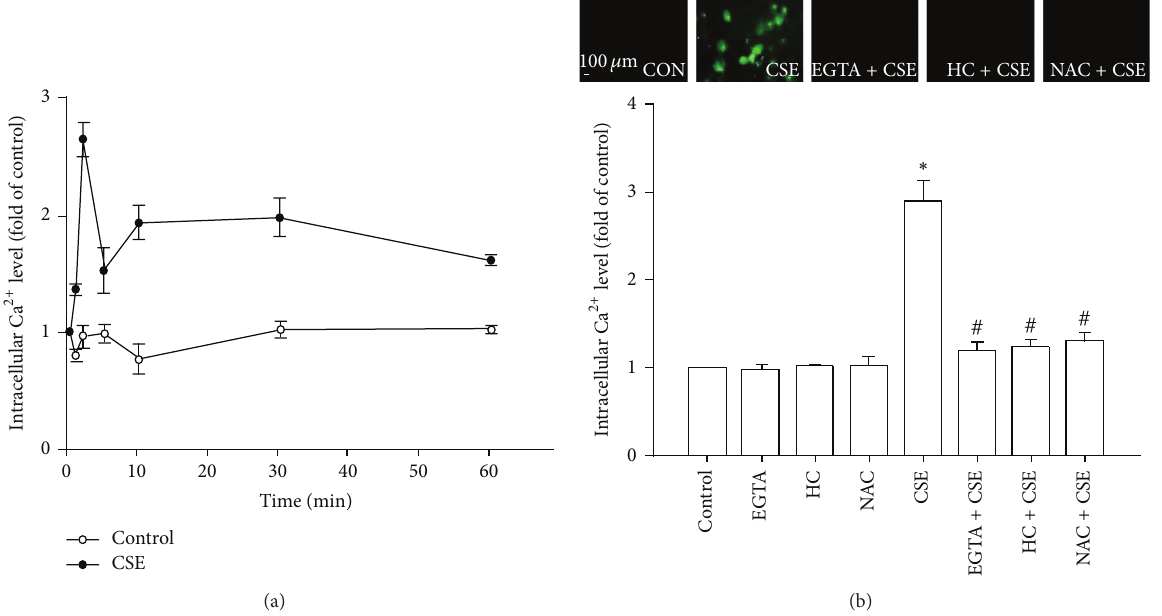
Figure3:CSEincreasestheintracellularCa 2+ levelviaTRPA1-mediatedioninfluxinHBECs.IntracellularCa 2+ levelsweremeasuredbyFluo- 8 fluorescent probe assay. (a) Cells were exposed to medium alone or 3% CSE for 1, 2, 5, 10, 30, and 60min. (b) Cells were exposed to medium alone or 3% CSE for 2min and pretreated with EGTA (an extracellular Ca 2+ chelator; 500 𝜇 M), HC-030031 (HC, a TRPA1 antagonist; 9 𝜇 M), or N-acetyl-cysteine (NAC, a ROS scavenger; 1mM). Data in each group are mean ± SEM from five independent experiments. ∗ 𝑝 < 0.05 versus the control or time zero; # 𝑝 < 0.05 versus CSE